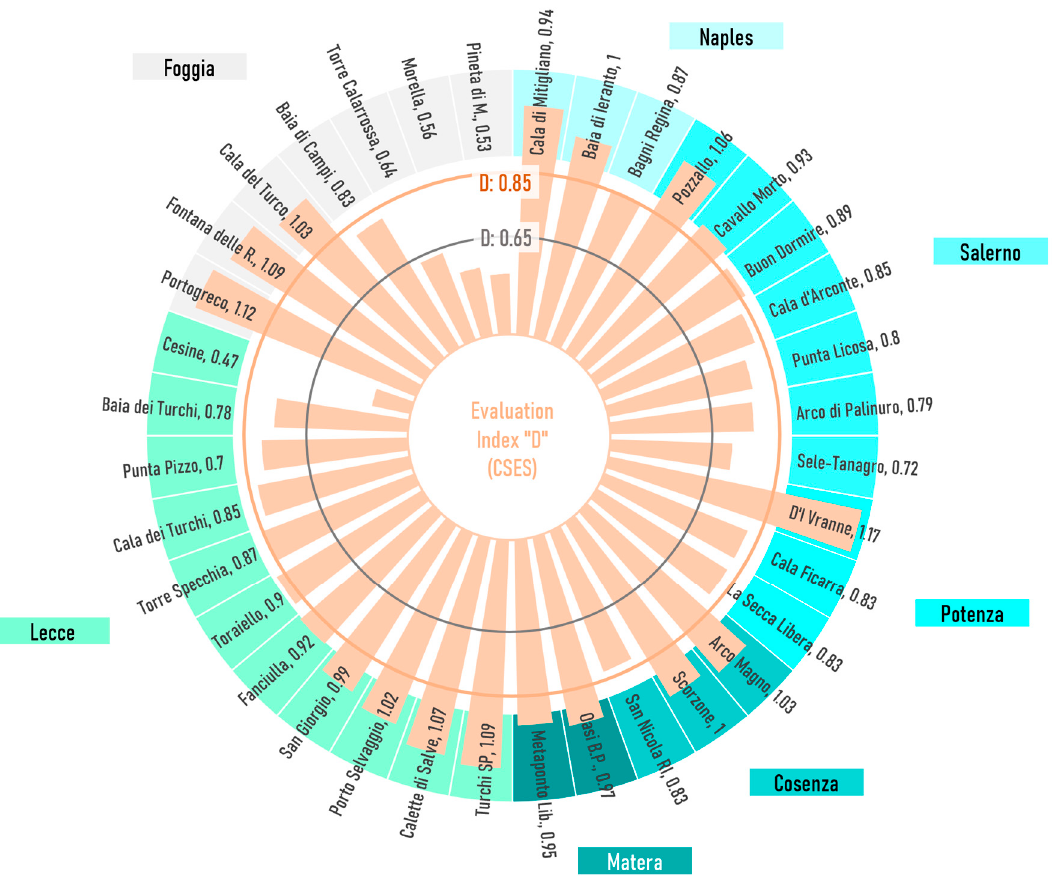
Figure 2. Site scores for evaluation index (D) presented according to the province to which they belong to, and limits of Class I (D ≥ 0.85), Class II (0.65 ≤ D < 0.85) and Class III (0.40 ≤ D < 0.65).